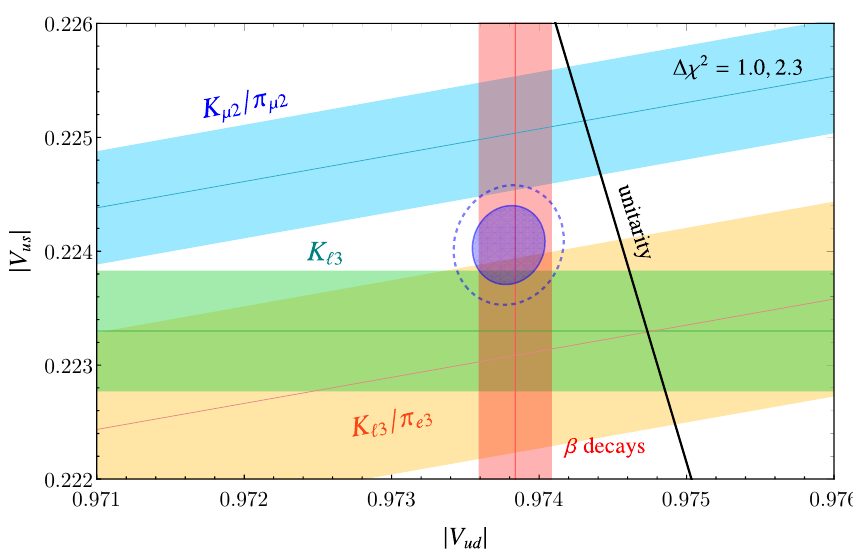
Figure 3 . Global fit of all the available CKM determinations with ∆ χ 2 = 1 (blue shaded) and ∆ χ 2 = 2 . 3 (dashed circle). Only the 1 σ regions from β decays, K ‘ 3 , K µ 2 /π µ 2 and K ‘ 3 /π e 3 observables are shown. The black line represents the unitarity condition.